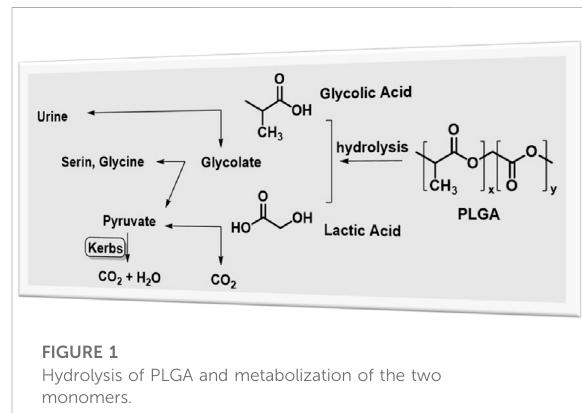
FIGURE 1 Hydrolysis of PLGA and metabolization of the two monomers.